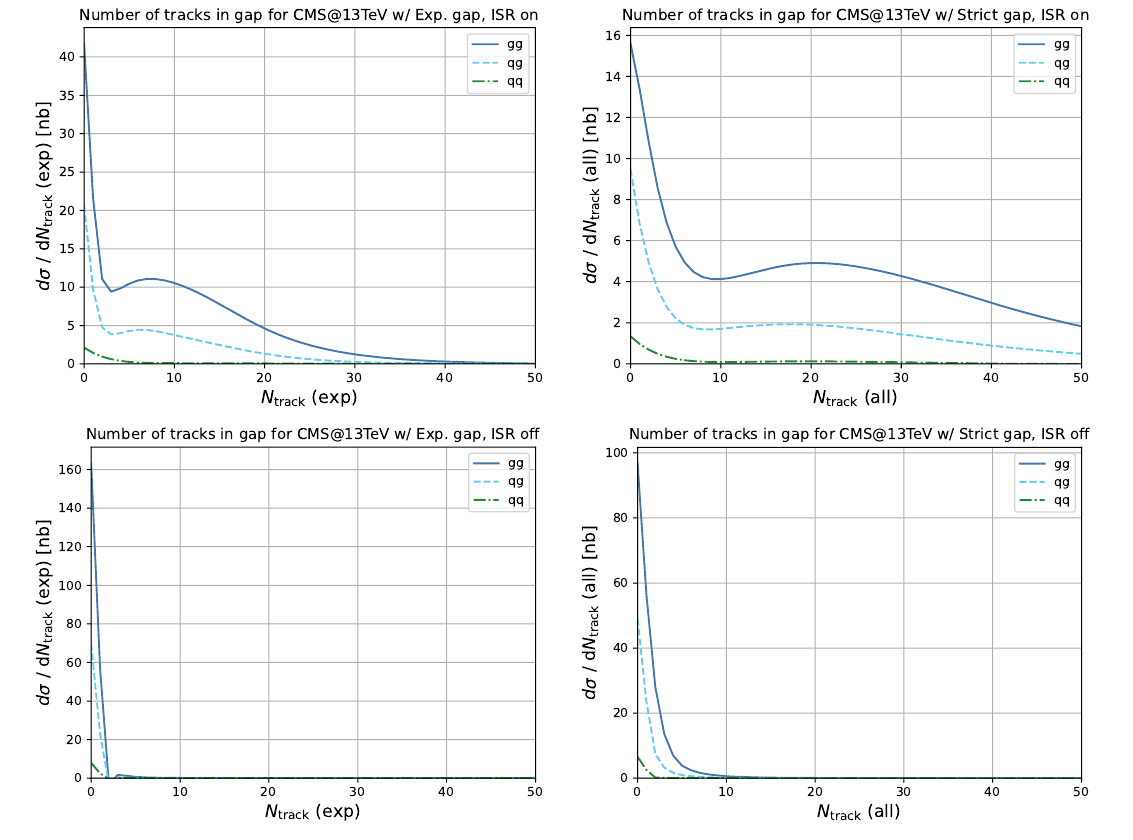
Figure 11 . N particle distributions in the | η | < 1 interval between the jets. The upper (lower) left panels correspond to ISR = on ( ISR = off ) for an experimental gap definition, the upper (lower) right panels correspond to ISR = on ( ISR = off ) for the strict gap definition. The ISR = on induces a “hump” due to the breaking of additional color strings that span wide intervals in rapidity, as explained in the text. The ISR = off is much cleaner, since there are not as many color strings attached to the forward and backward color charges. These plots are created with the CMS @ 13 TeV analysis